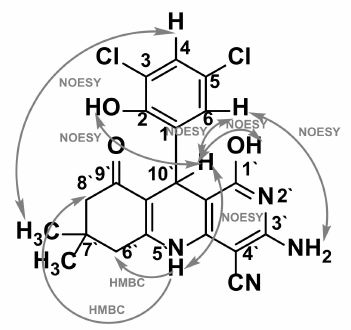
Figure 6. The structure 10-(3,5-dichloro-2-hydroxyphenyl)-5,6,7,8,9,10-hexahydrobenzo[ b ][1,6]- naphthyridines 3a . Key 2D NMR correlations are shown by